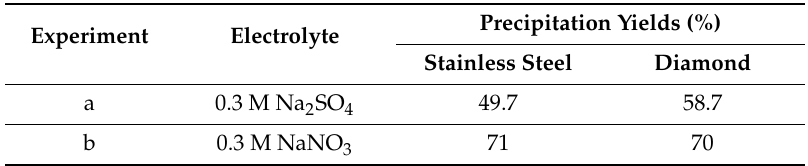
Table 2. Precipitation yields of 5.96 Bq 241 Am electro-precipitated for t = 90 min: (a) 0.3 M Na 2 SO 4 electrolyte pH 3.97 (stainless steel) or 3.85 (diamond), current density = 8.0 mA.cm -2 , and (b) 0.3 M